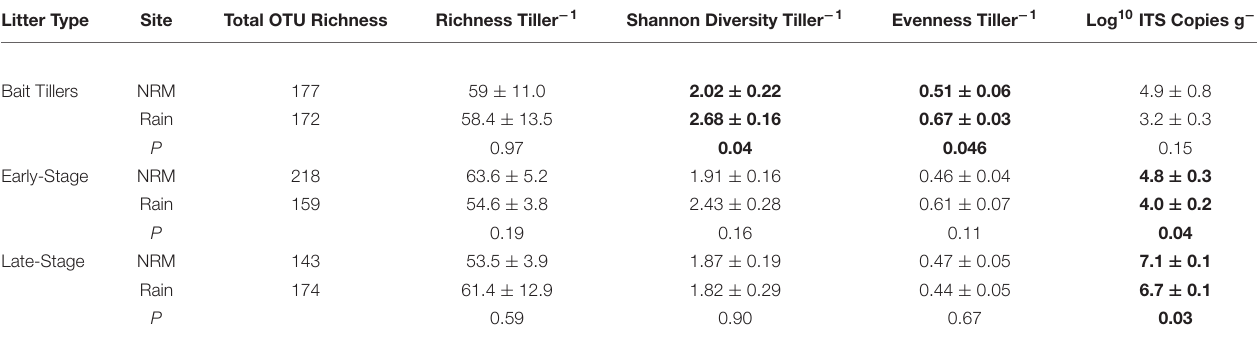
TABLE 3 | Comparisons of air-derived and litter-associated fungal communities at each site. Values are only for native (i.e., non-transplanted) tillers. Litter